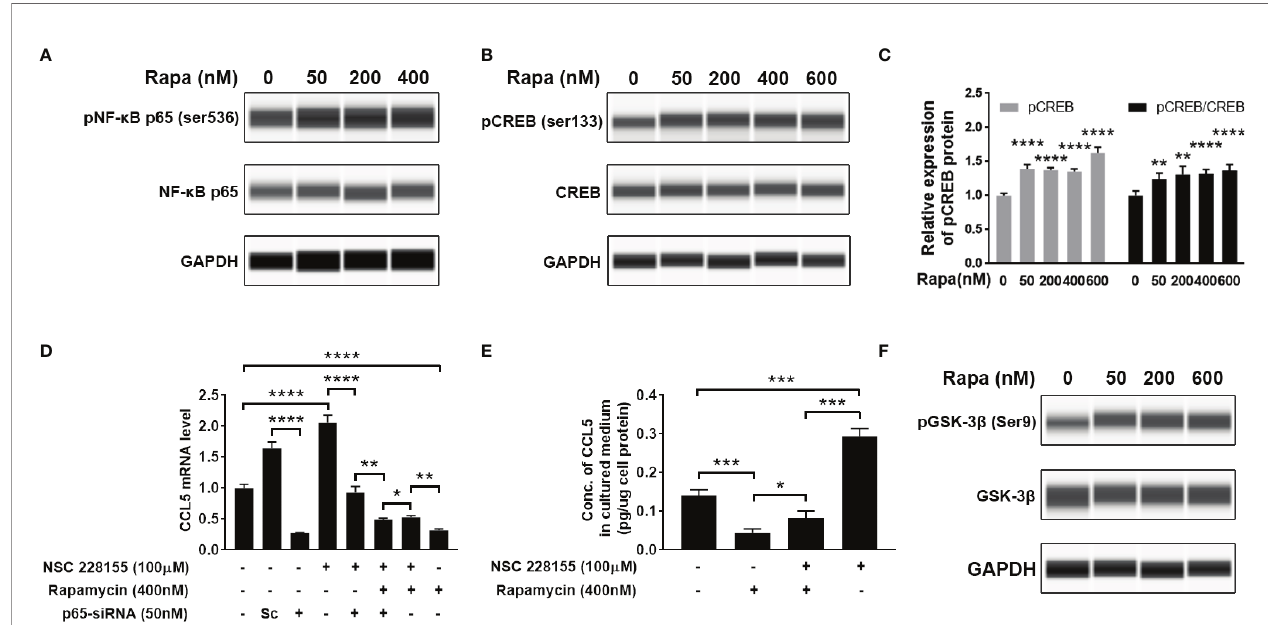
FIGURE 6 | Cross-talk between mTOR signaling cascades, NF- k B, and CREB regulates the production of CCL5. HMC3 cells were treated with rapamycin (Rapa, 0-600nM) for 48 h, and the activation of NF- k B and mTOR signaling was assessed. (A) The total and phosphorylated levels of p65 subunit of NF- k B were analyzed by Western blotting, and GAPDH served as the loading control. (B) The total and phosphorylated levels of CREB were analyzed by Western blotting, and (C) active CREB (pCREB) protein level is further quanti fi ed (n=5 each group). (D) Transcriptional cross-talk between CREB, NF- k B, and mTOR pathway. NSC 228155 rescued the mTOR inhibitor (rapamycin)-mediated reduction of the gene expression level of CCL5, while p65-siRNA further counteracted NSC 228155 ’ s stimulating effect on CCL5 expression. The gene expression level of the CCL5 was determined by qRT-PCR (n=3 each group). (E) NSC 228155 reversed the repressive effect of rapamycin on CCL5 production. The concentration of CCL5 protein in the cell culture medium was measured by ELISA (n=3 each group). (F) The total and phosphorylated levels of GSK-3 b were analyzed by Western blotting. Data are presented as mean ± SD. Statistical signi fi cance was determined by Student- t test and denoted by * p < 0.05, ** p < 0.01, *** p < 0.001, and **** p <